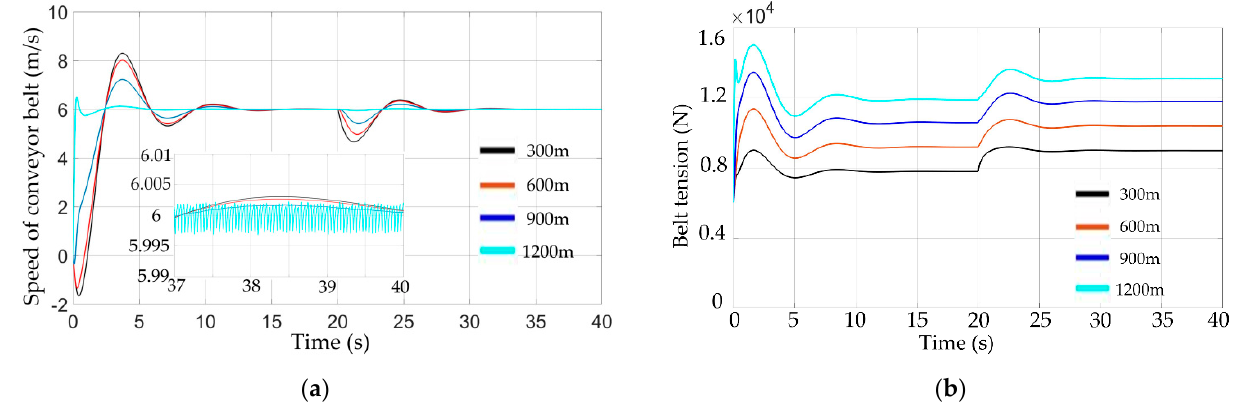
Figure 14. The response curve of conveyor belt on traditional belt conveyor system under variable load operation conditions. ( a ) Velocity curve; ( b ) Tension curve.